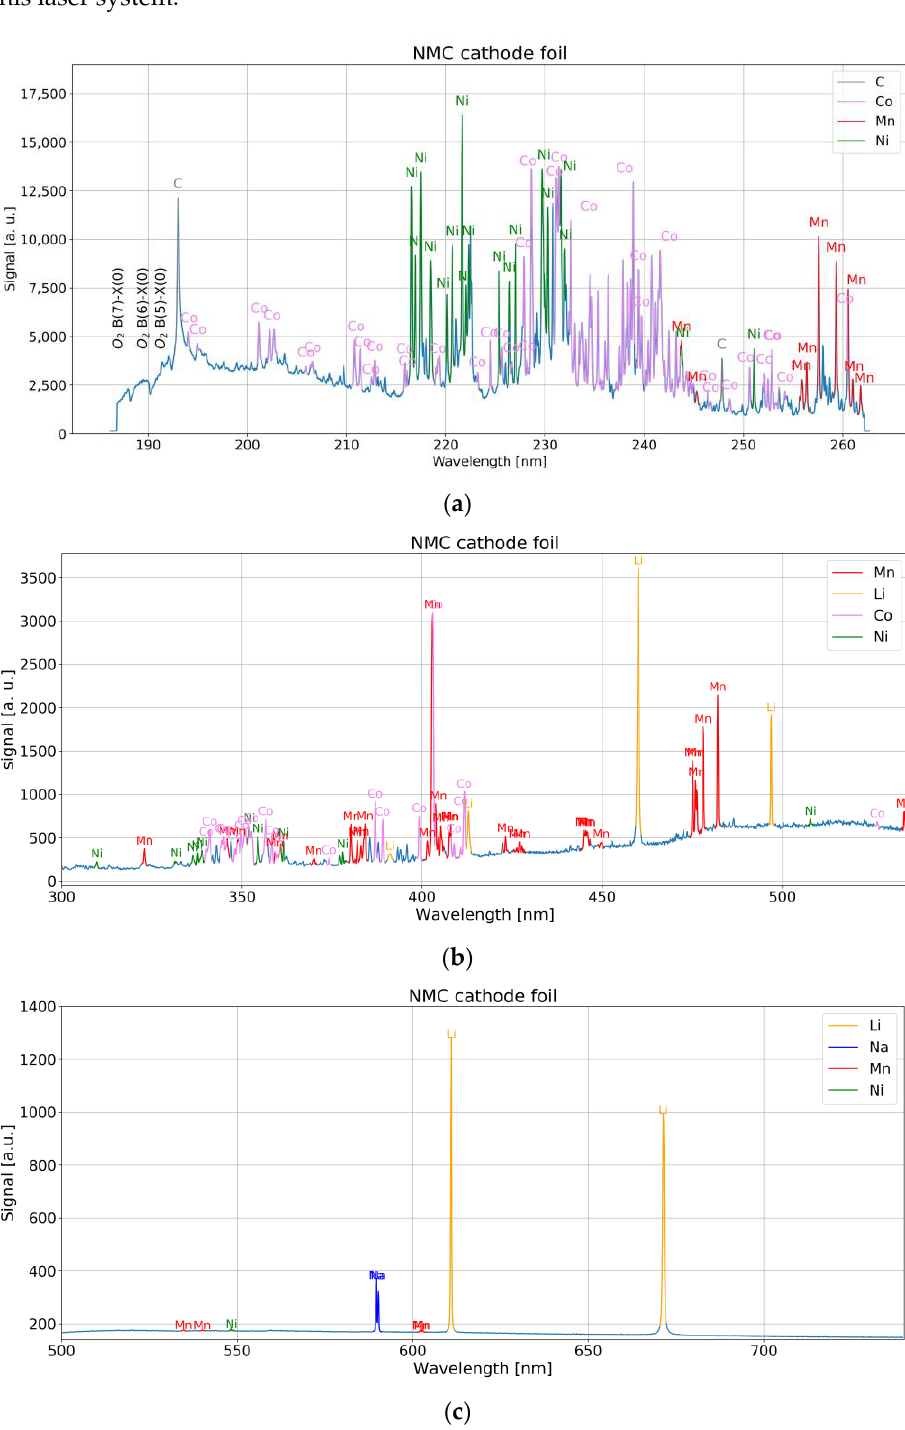
Figure 7. ( a ). UV spectrum of NMC cathode foil with 6 mJ pulse energy. ( b ). Near-UV-VIS spectrum Figure 7. ( a ) UV spectrum of NMC cathode foil with 6 mJ pulse energy. ( b ) Near-UV-VIS spectrum of NMC cathode foil with 1 mJ pulse energy. ( c ). VIS spectrum of NMC cathode foil with 1 mJ pulse of NMC cathode foil with 1 mJ pulse energy. ( c ) VIS spectrum of NMC cathode foil with 1 mJ energy. pulse